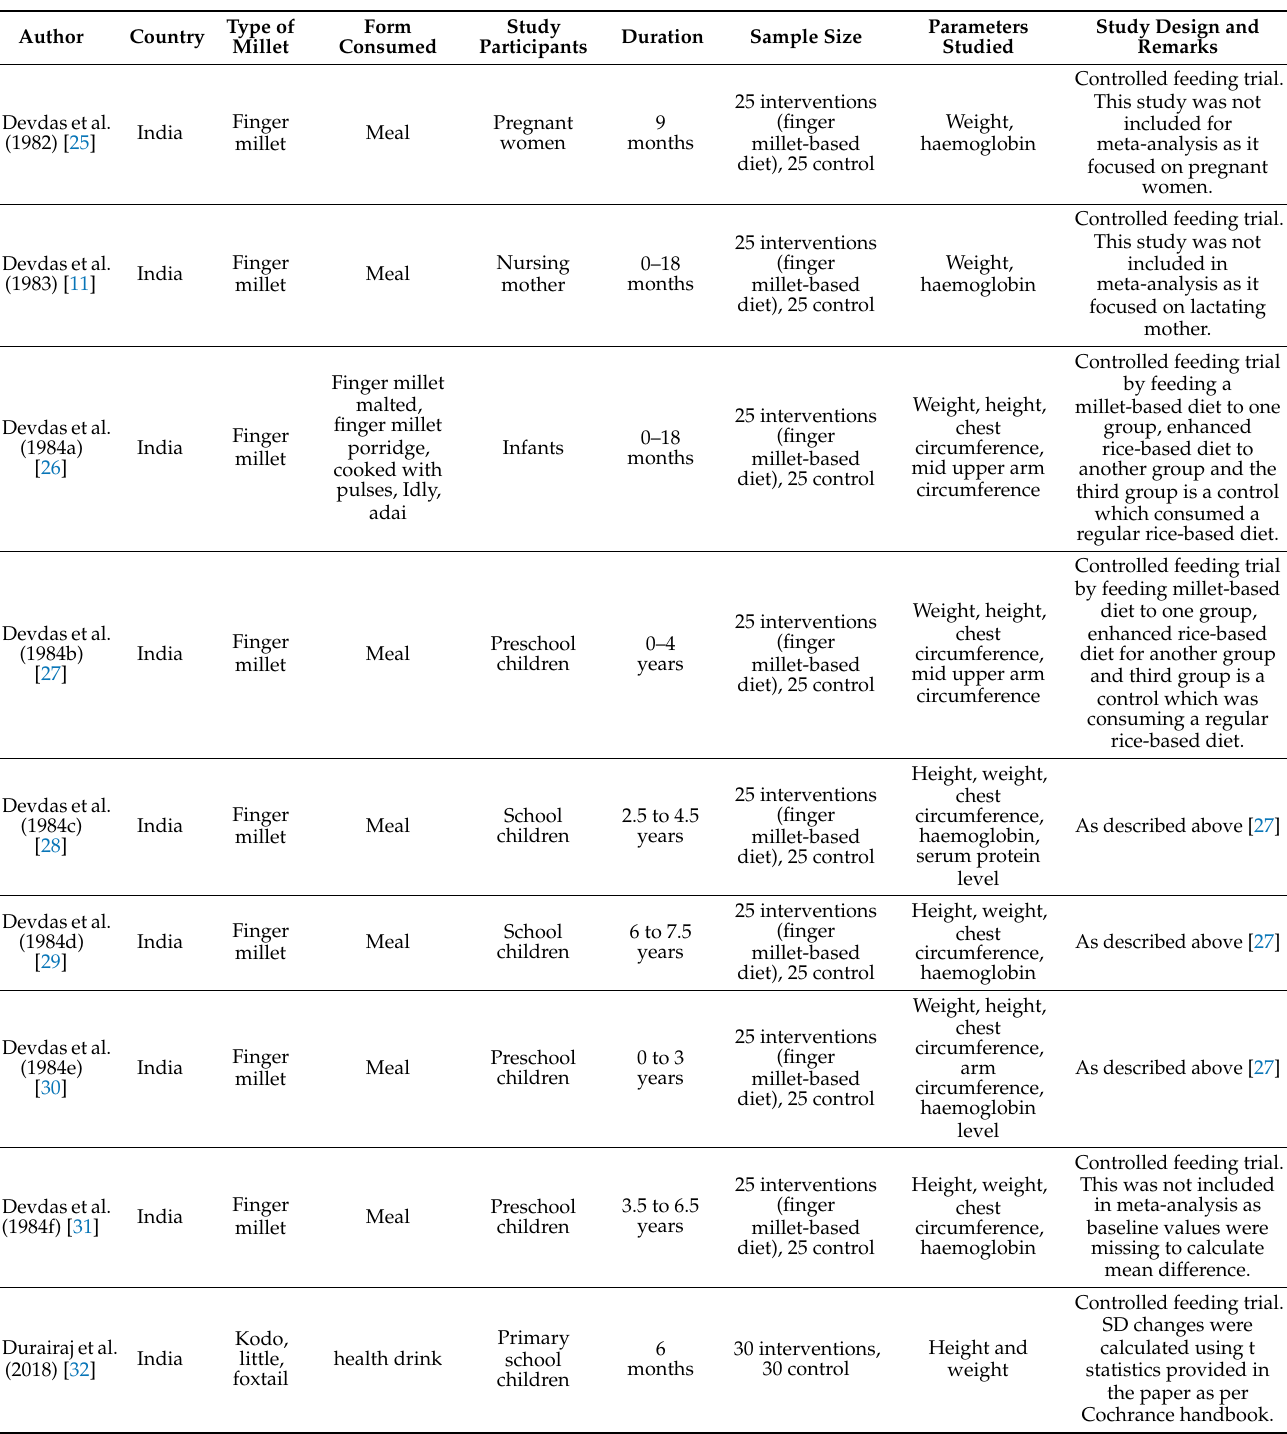
Table 2. Characteristics of the studies evaluated for final inclusion in the systematic review and